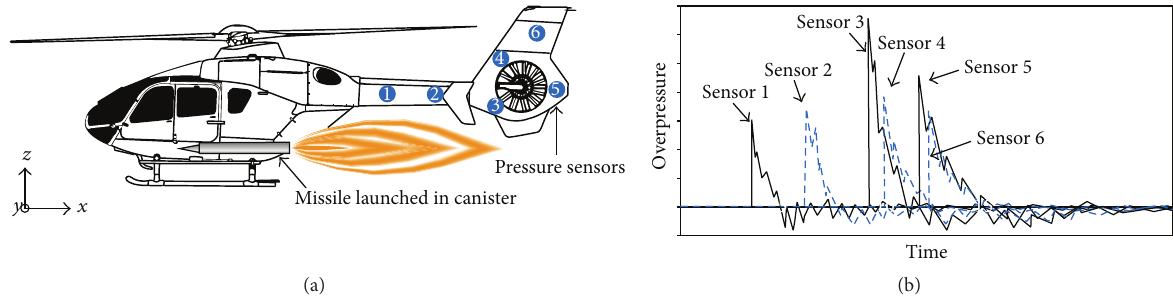
Figure 2: Illustration (side view) of missile launch tests from helicopter with highlighted pressure sensors (a) and qualitative illustration of the pressure-time results